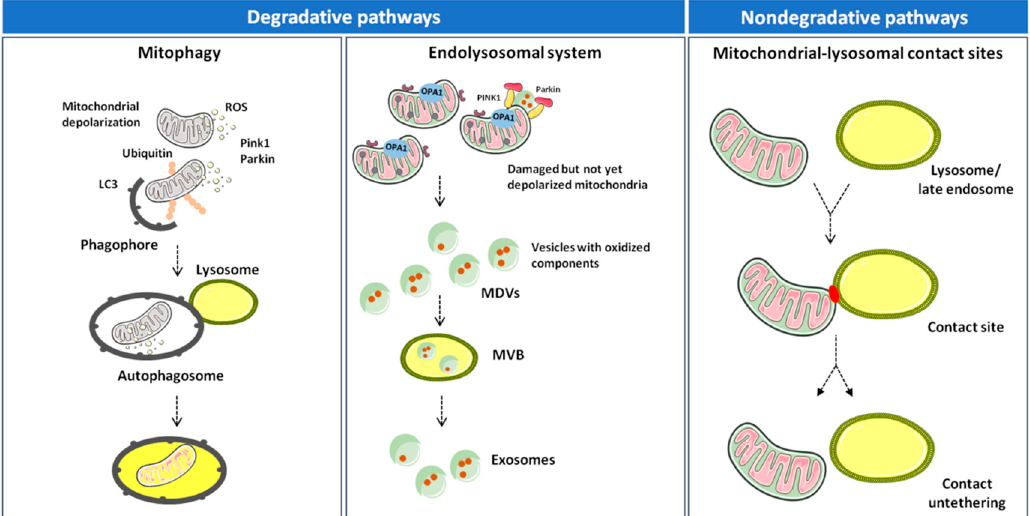
Figure 1. Degradative and nondegradative pathways in mitochondrial quality control. Mitochondrial dynamics are ensured by several factors that regulate fusion (mitofusin (MFN) 1, MFN2, and optic atrophy 1 (OPA1)) and fission (dynamin-related protein 1 (DRP1) and mitochondrial fission 1 protein (FIS1)). While fusion dilutes organellar damage along the network, fission targets dysfunctional mitochondria and triggers their clearance through mitophagy in a phosphatase and tensin homolog (PTEN)-induced putative kinase 1 (PINK1)/Parkin–dependent manner. Mildly damaged mitochondria and organellar components may be recycled via the generation of mitochondrial derived vesicles (MDVs). Once formed, MDVs reach out the endolysosomal system, form multivesicular bodies (MVBs), and are released into the extracellular space as exosomes. Abbreviations: LC3, microtubule-associated proteins 1A/1B light chain 3 and ROS, reactive oxygen species.